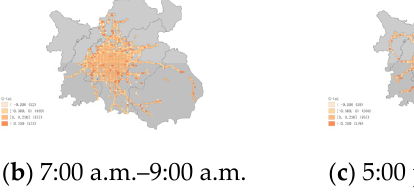
Figure 10. ( a ) Grid traffic state index (G-tsi) of each grid area at 1:00 a.m.–3:00 a.m. ( b ) Grid traffic state index (G-tsi) of each grid area at 7:00 a.m.–9:00 a.m. ( c ) Grid traffic state index (G-tsi) of each grid area at 5:00 p.m.–7:00 p.m. ( d ) Grid traffic state index (G-tsi) of each grid area at 8:00 p.m.–10:00 p.m.